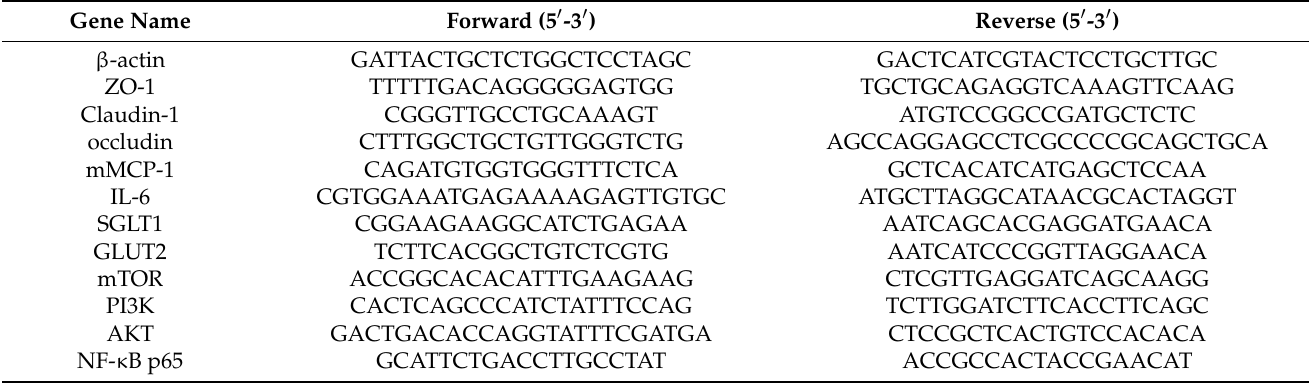
Table 1. List of primer pairs used for real-time quantitative